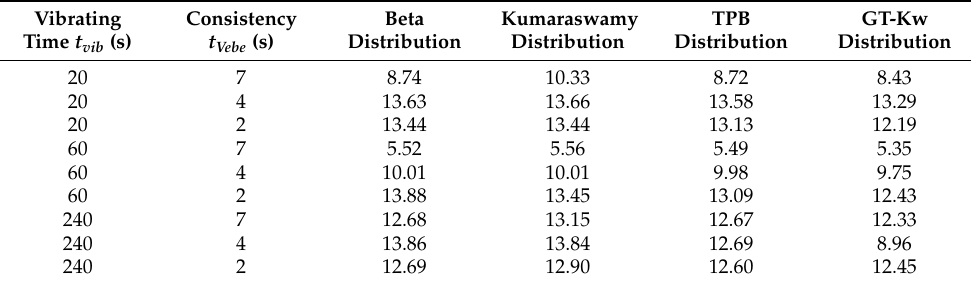
Table 4. Chi-square test ( χ 2 ) results